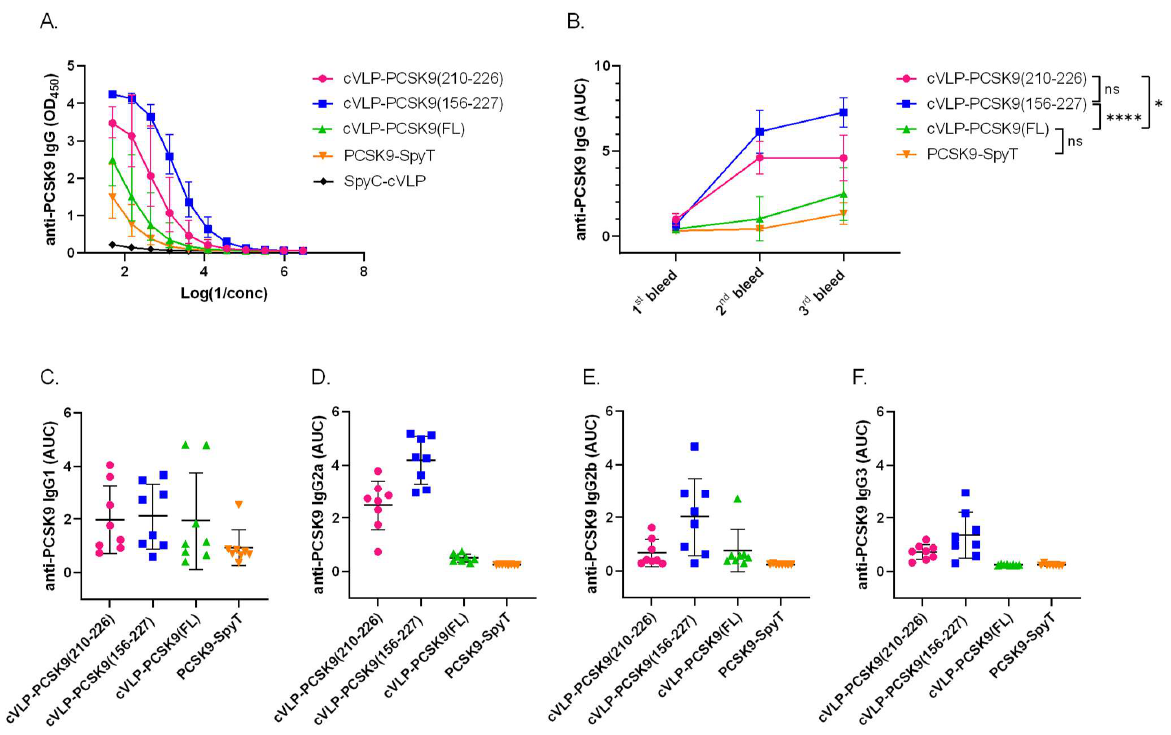
Figure 4. cVLP-PCSK9 vaccines induce antigen-specific antibody titers in mice. Plasma samples were obtained from male BALB/c mice ( n = 8 per group) two weeks after prime (1st bleed), boost (2nd bleed) and second boost (3rd bleed), respectively. ( A ). Total IgG anti-PCSK9 dilution curve (3rd bleed) detected in mice vaccinated with cVLP-PCSK9(210–226) (pink), cVLP-PCSK9(156–227) (blue), cVLP-PCSK9(FL) (green), soluble PCSK9-SpyT (orange) or unconjugated SpyC-cVLP (black).